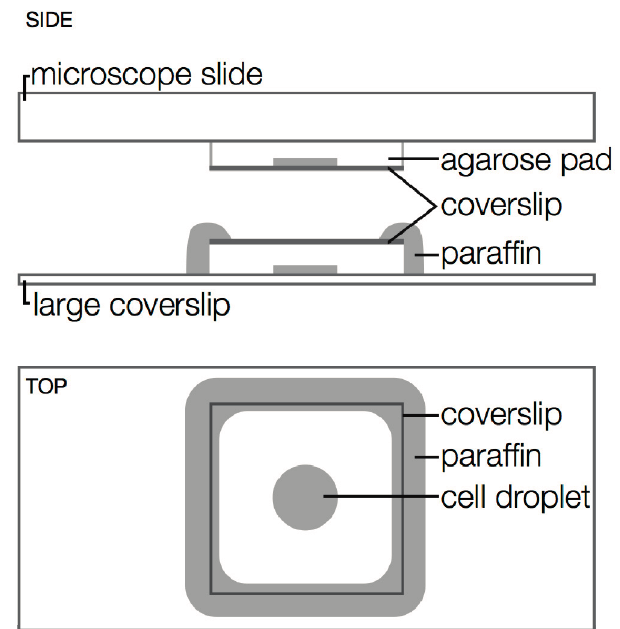
Figure 9. Microscopy sample geometry. Top: unsealed sample on a microscope slide. Middle and Bottom: sample sealed with paraffin wax. Side views are oriented as in an inverted microscope setup (objective at